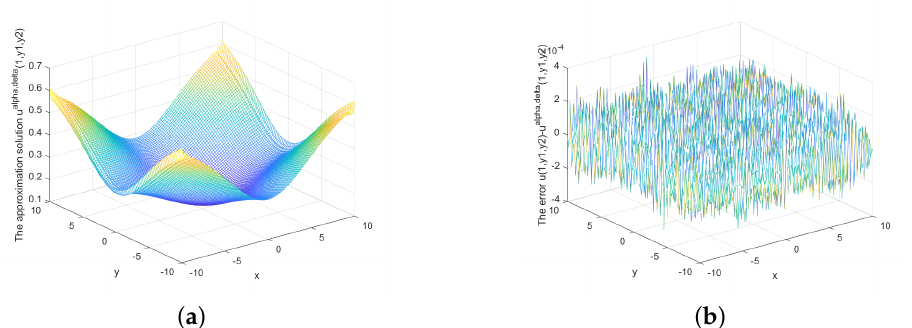
Figure 14. ( a ) The regularized solution and ( b ) error between regularized and exact solution when x = 0.3, δ = 1 × 10 − 6 under a priori